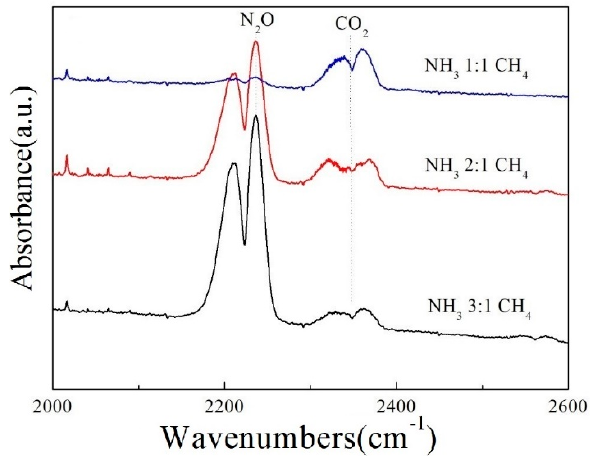
Figure 7. FTIR spectra and products detected in the DBD-NH 3 -CH 4 -SCR with different ratios of NH 3 and CH 4 . Experimental conditions: 2% O 2 , SIE 512 J/L, NH 3 1:1 CH 4 : 45 ppm NH 3 and 45 ppm CH 4 , NH 3 2:1 CH 4 : 60 ppm NH 3 and 30 ppm CH 4 , NH 3 3:1 CH 4 : 67.5 ppm NH 3 and 22.5 ppm CH 4 .